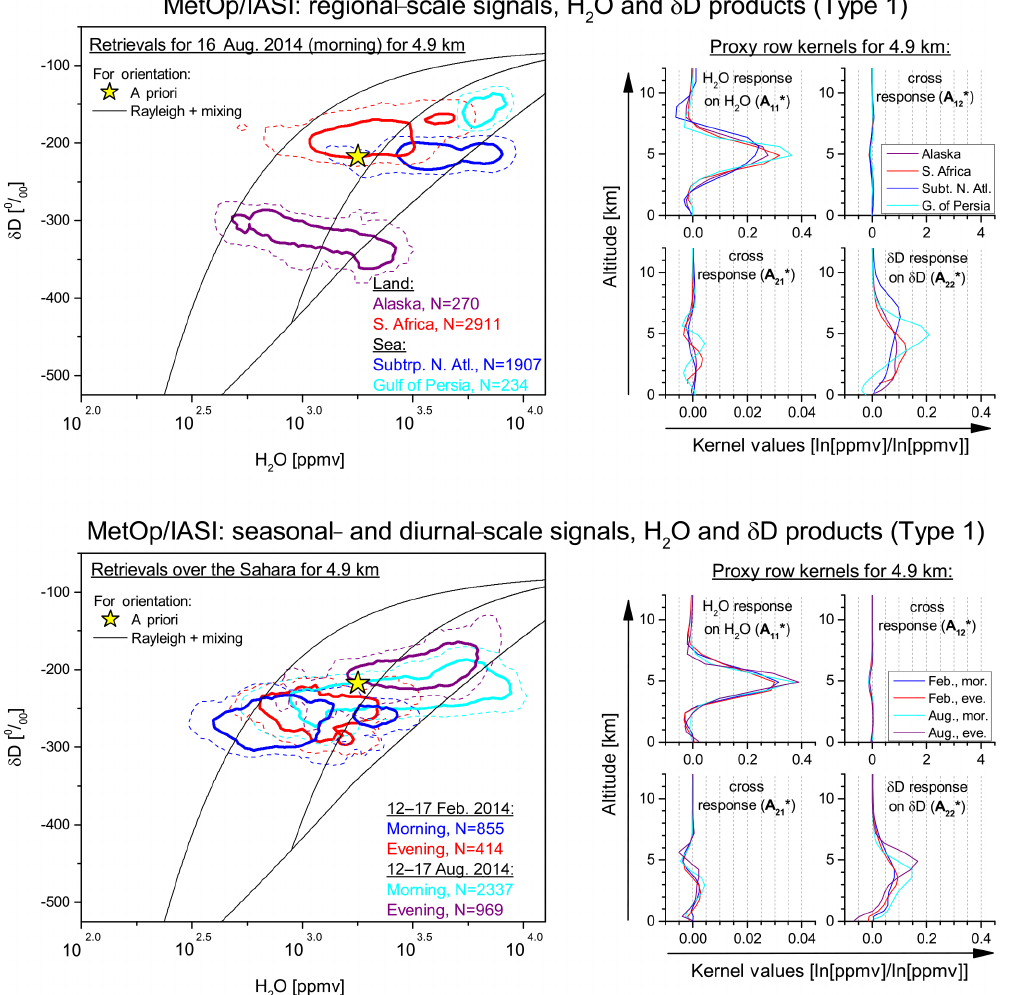
Figure 12. Same as Fig. 10, but instead of the {H 2 O, δ D} pair product (a posteriori corrected product), the plots are for the direct H 2 O and δ D retrieval output (Type 1, no a posteriori correction). Please note the different scale on the x axis of the row kernel plots compared to Fig.